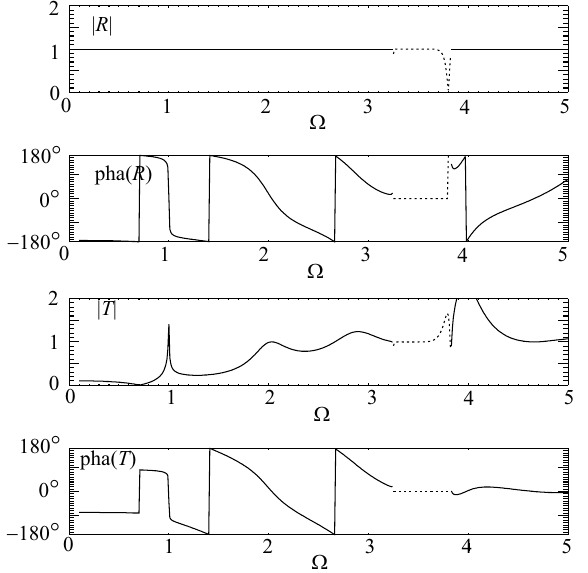
Fig. 7. Reflection coefficient contours when the magnetosheath